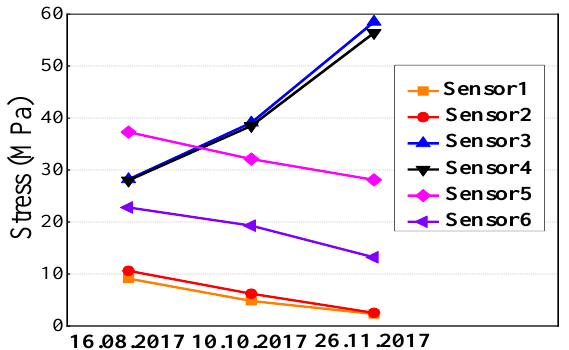
Figure 7. Schematic diagram of the arrangement of reinforced stress gauges in concrete piers.